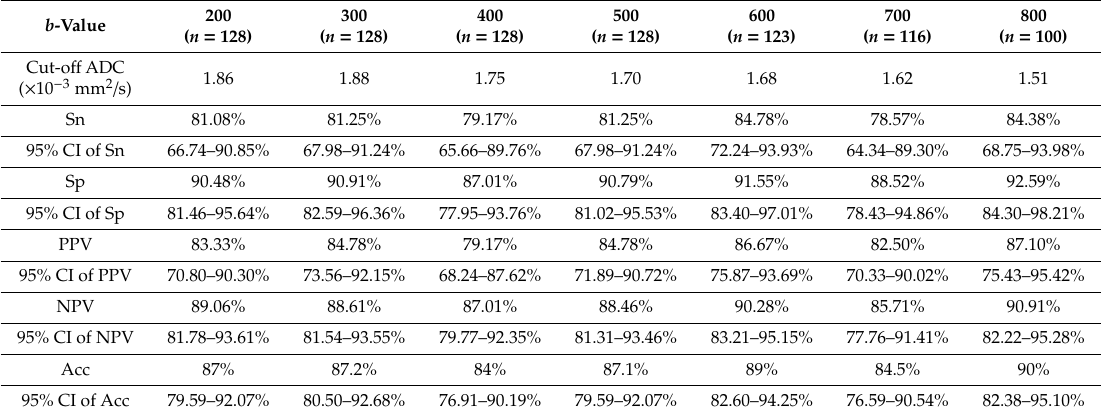
Table 3. Cut-o ff point of ADC with each b factor and value of the